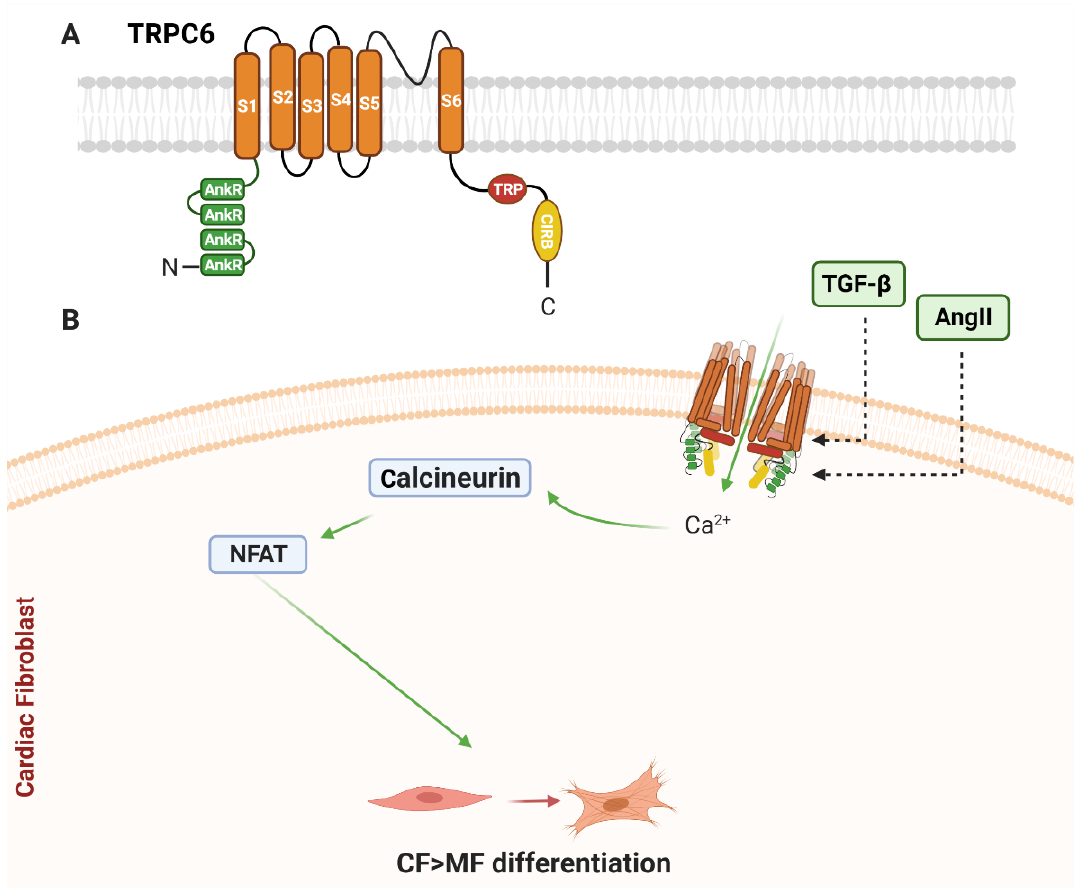
Figure 2. Schematic diagram of TRPC6 structure and signalling in cardiac fibroblasts. ( A ) Basic structure of alpha subunit of TRPC6. Each TRPC6 alpha subunit is comprised of six transmembrane-spanning domains (S1–S6), with a pore loop between S5 and S6, ankyrin repeats (AnkR) at the amino terminus, and a TRP-box (TRP) and calmodulin- and IP3 receptor-binding (CIRB) domain at the carboxyl termini. ( B ) Known TRPC6 homotetrameric ion channel signalling in cardiac fibroblasts. Ang II and TGF- β can upregulate cardiac fibroblast TRPC6 gene expression resulting in increased Ca 2+ influx. TRPC6-mediated Ca 2+ entry is coupled to cardiac myofibroblast differentiation via activation of the calcineurin–NFAT signalling pathway. See main text for details.